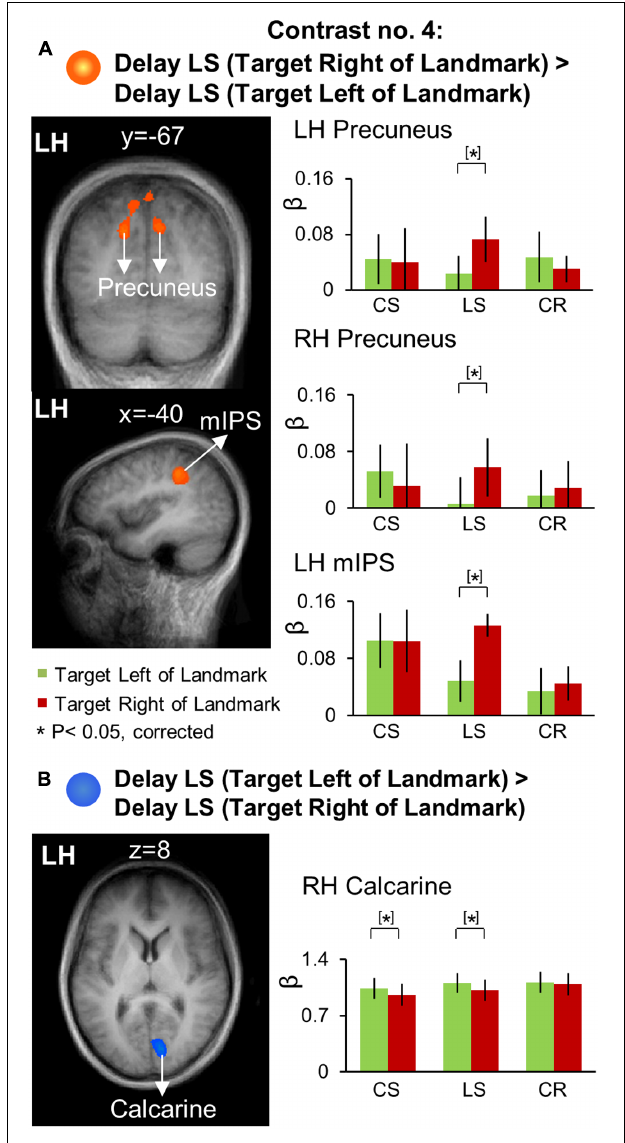
FIGURE 8 | Voxelwise activation maps obtained with the RFX GLM and activation levels for each area using Contrast no. 4. (A) [Delay LS (Target Right of Landmark) > Delay LS (Target Left of Landmark)]. (B) [Delay LS (Target Left of Landmark) > Delay LS (Target Right of Landmark)]. Left panels: activation maps overlaid on the averaged anatomical image from all participants. Right panels: bar graphs show the β weights for each condition in each area. Legends as in Figure 2